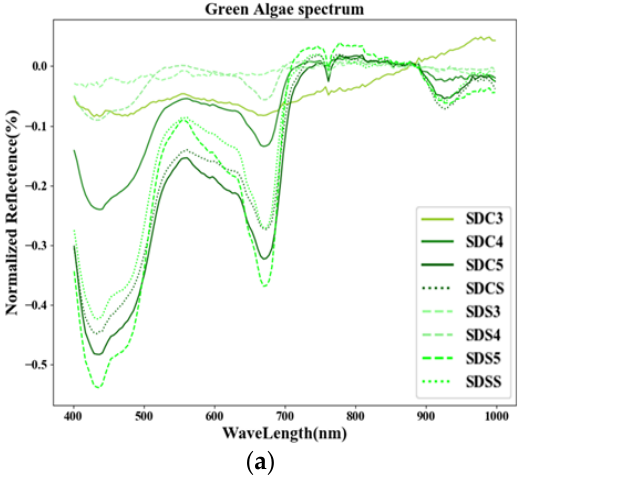
Table 3. Absorption wavelength range of selected green algae.